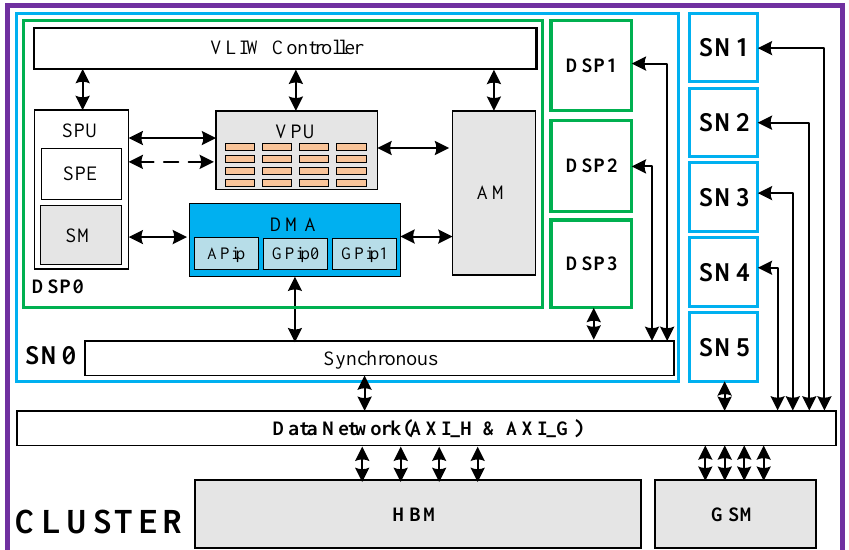
Figure 2. Cluster overview.